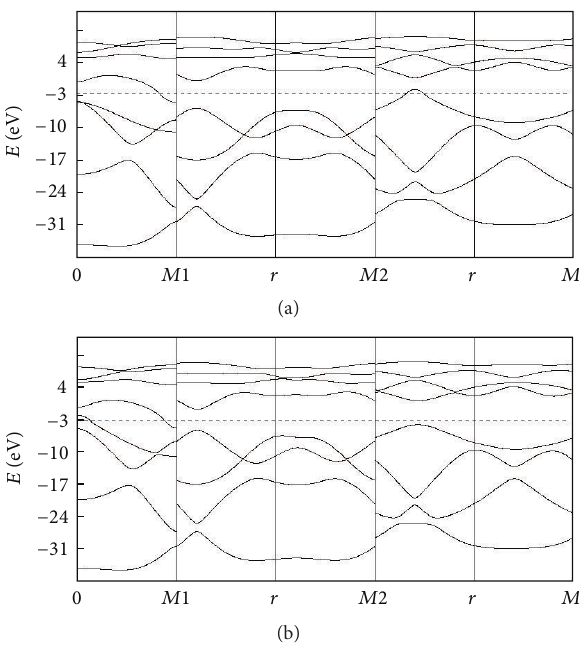
Figure 6: Effect of electron-vibration coupling on band structure topology at Fermi level for [(5,0),91] -type SWSiNT. Band structure at (a) equilibrium undergoes topology change at Fermi level for (b) displacement of 0.039 ˚A/Si-atom out of equilibrium at vibration motion in stretching Si–Si mode; cf. path 0- 𝑀 for (a)/(b) panels.